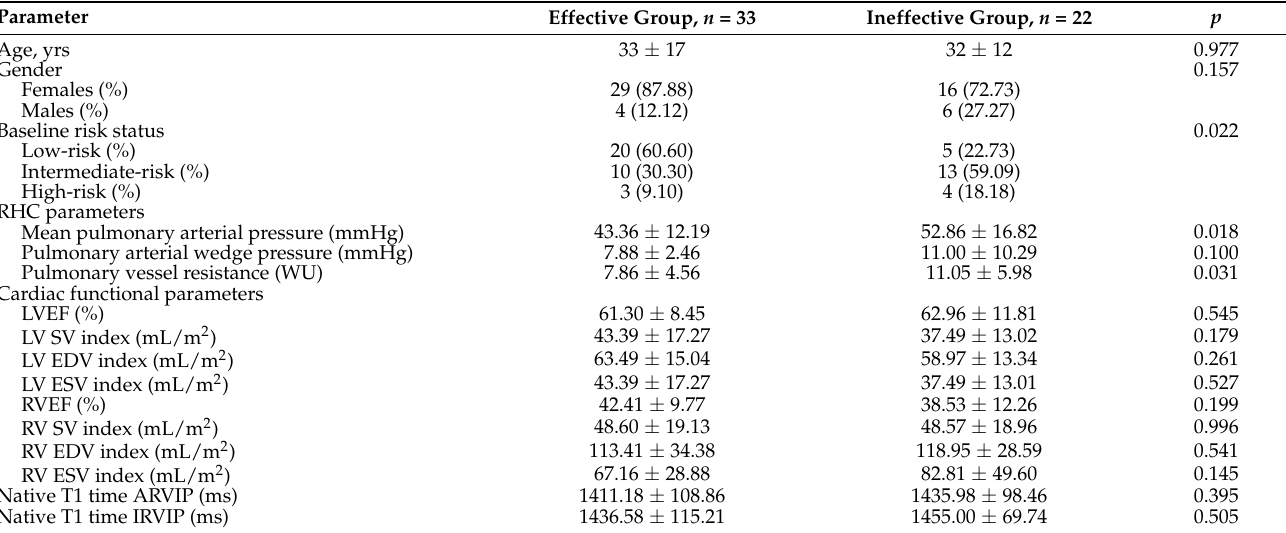
Table 1. Demographic and clinical characteristics of PAH patients.